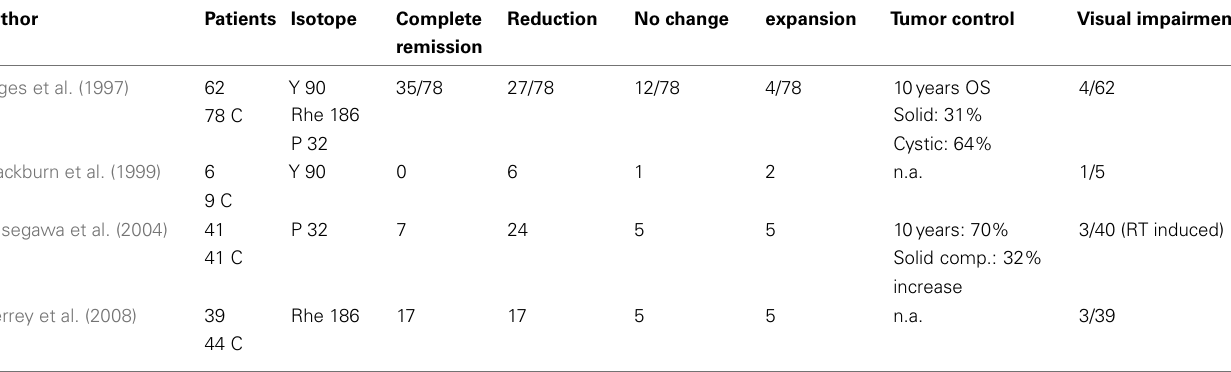
Table 5 | Intracavitary instillation of radionuclides/impact on tumor control and visual function (modified according to Derrey et al., 2008).